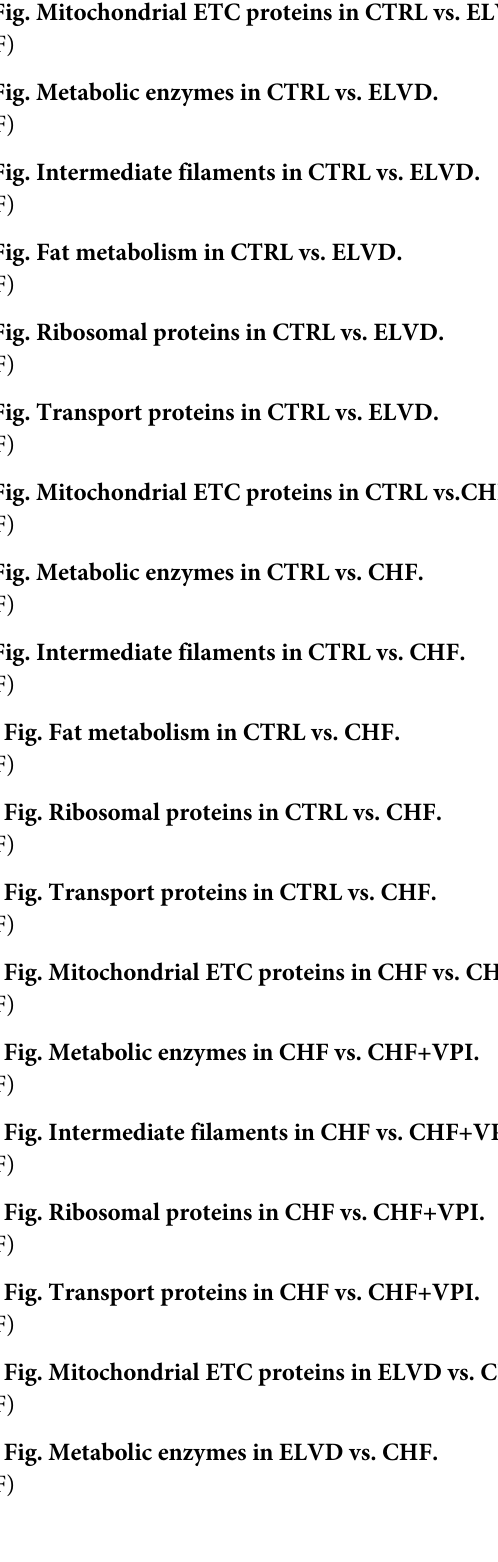
S1 Fig. Mitochondrial ETC proteins in CTRL vs. ELVD. (TIF) S2 Fig. Metabolic enzymes in CTRL vs. ELVD. (TIF) S3 Fig. Intermediate filaments in CTRL vs. ELVD. (TIF) S4 Fig. Fat metabolism in CTRL vs. ELVD. (TIF) S5 Fig. Ribosomal proteins in CTRL vs. ELVD. (TIF) S6 Fig. Transport proteins in CTRL vs. ELVD. (TIF) S7 Fig. Mitochondrial ETC proteins in CTRL vs.CHF. (TIF) S8 Fig. Metabolic enzymes in CTRL vs. CHF. (TIF) S9 Fig. Intermediate filaments in CTRL vs. CHF. (TIF) S10 Fig. Fat metabolism in CTRL vs. CHF. (TIF) S11 Fig. Ribosomal proteins in CTRL vs. CHF. (TIF) S12 Fig. Transport proteins in CTRL vs. CHF. (TIF) S13 Fig. Mitochondrial ETC proteins in CHF vs. CHF+VPI. (TIF) S14 Fig. Metabolic enzymes in CHF vs. CHF+VPI. (TIF) S15 Fig. Intermediate filaments in CHF vs. CHF+VPI. (TIF) S16 Fig. Ribosomal proteins in CHF vs. CHF+VPI. (TIF) S17 Fig. Transport proteins in CHF vs. CHF+VPI. (TIF) S18 Fig. Mitochondrial ETC proteins in ELVD vs. CHF. (TIF) S19 Fig. Metabolic enzymes in ELVD vs. CHF.